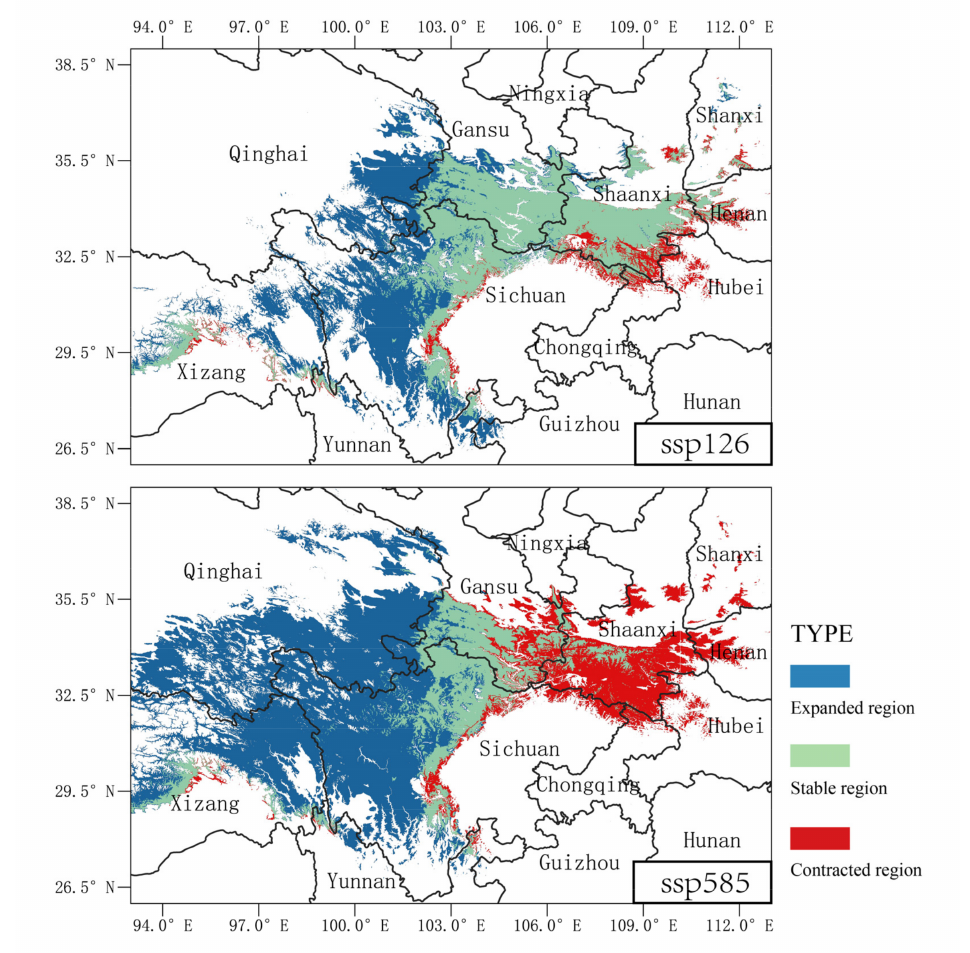
Figure 7. Changes of the potential distribution of H. thibetanus in the 2070s in two scenarios (ssp126 and